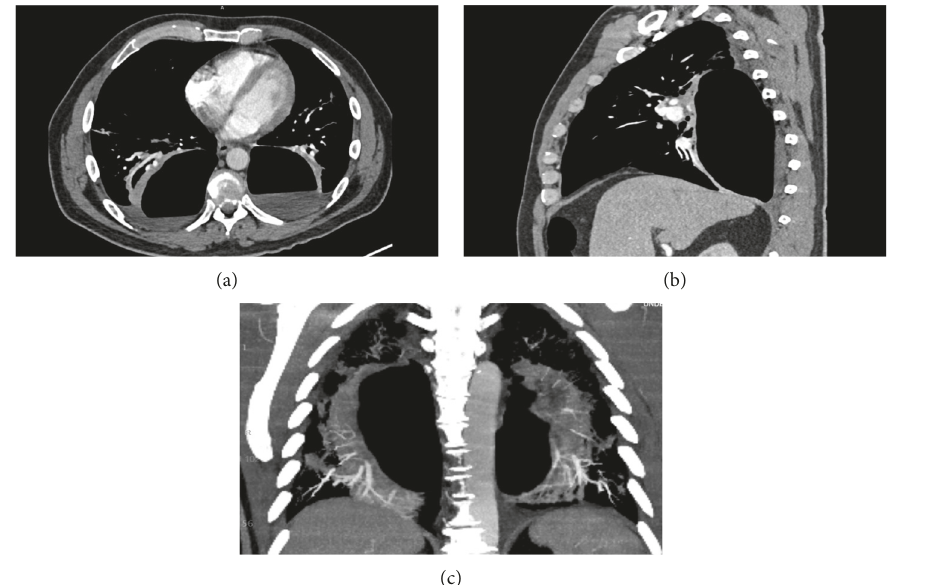
Figure 1: CTA from the outside hospital imaged prior to transfer demonstrating large cystic lesions in the (a) axial, (b) sagittal, and (c) coronal views.